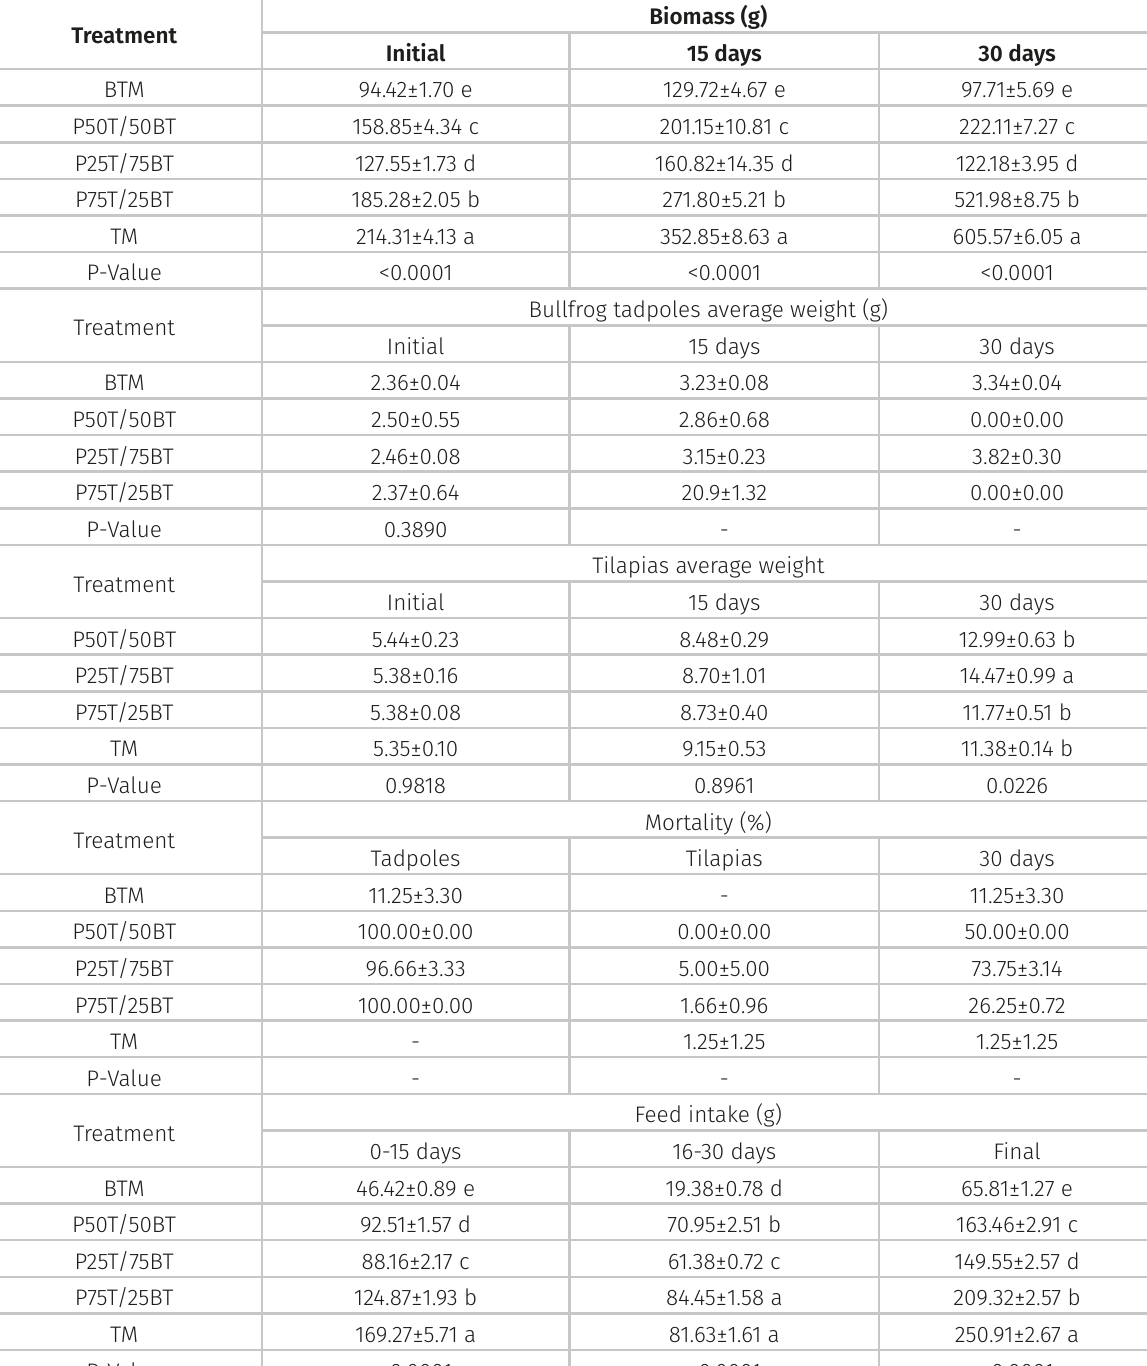
Table II. Biomass (g), average weight (g), mortality (%) e feed intake (%) of the polyculture (P) breeding of Nile tilapias fingerlings (T) and bullfrog tadpoles (BT), tilapia monoculture (TM) and a bullfrog tadpole monoculture (BTM) in the experiment